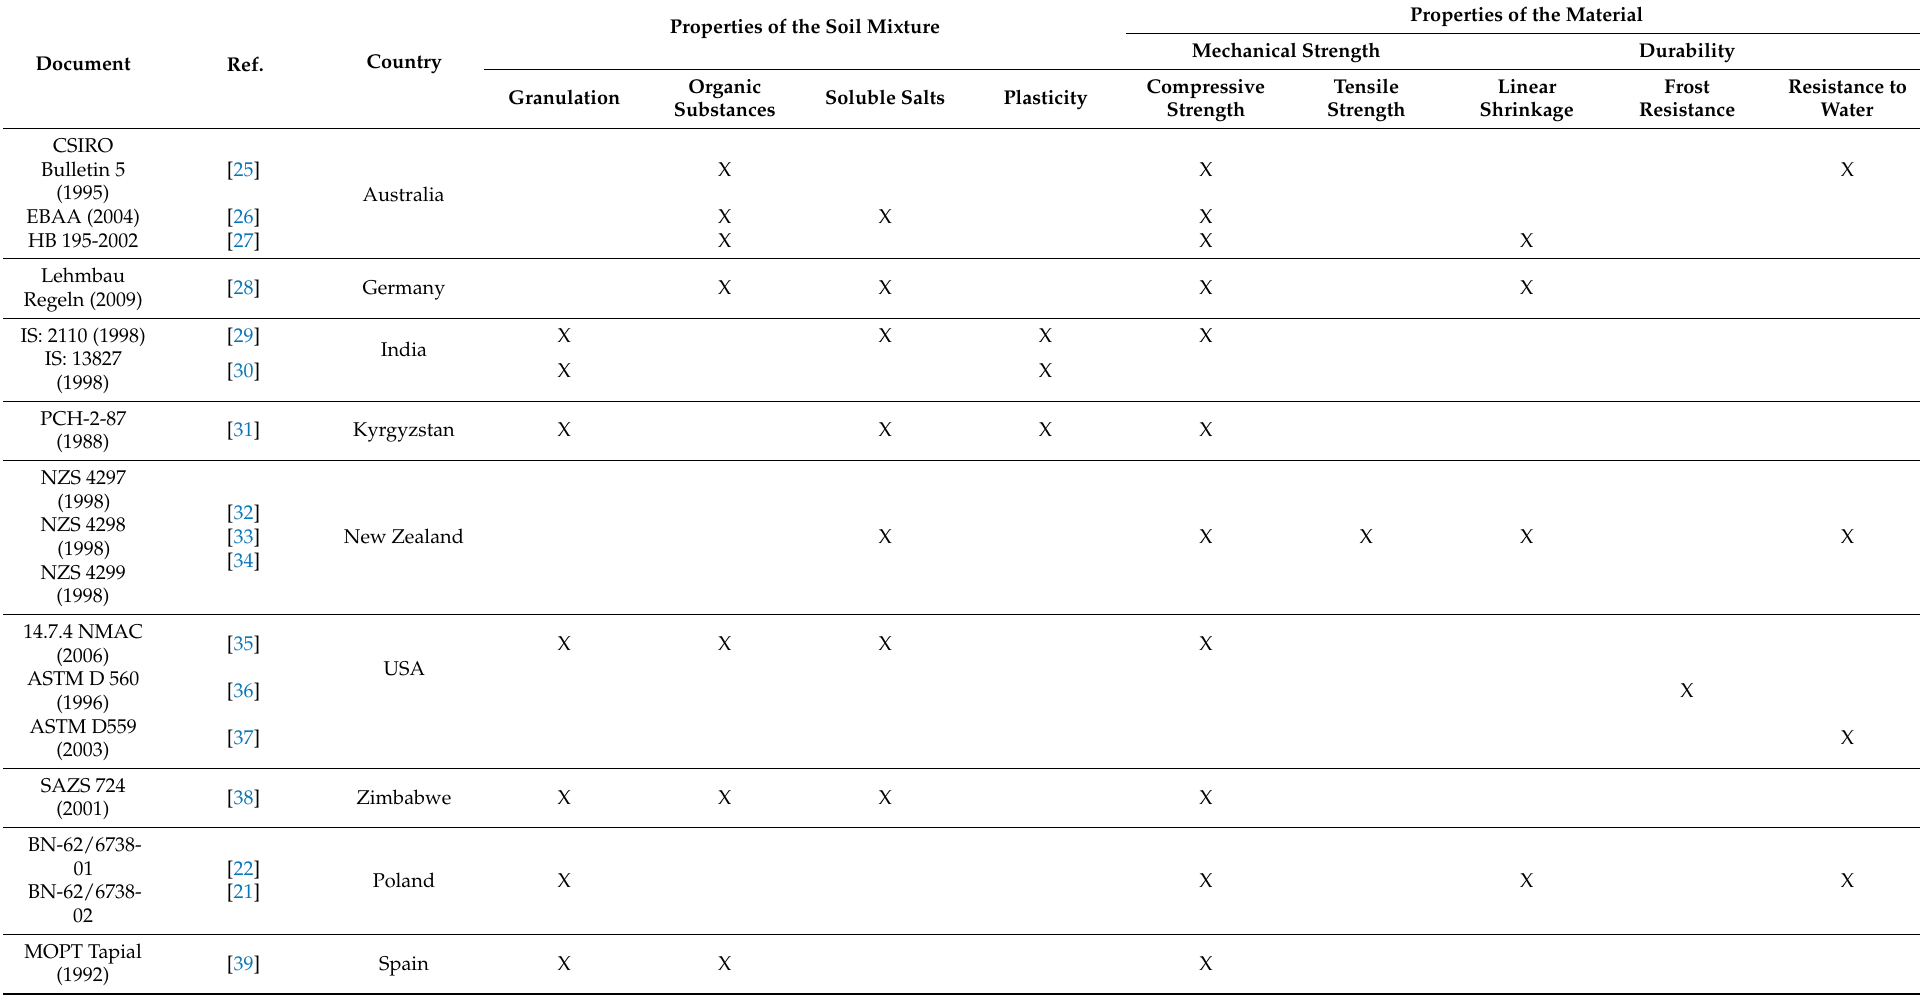
Table 1. Characteristics of rammed earth included in the standards